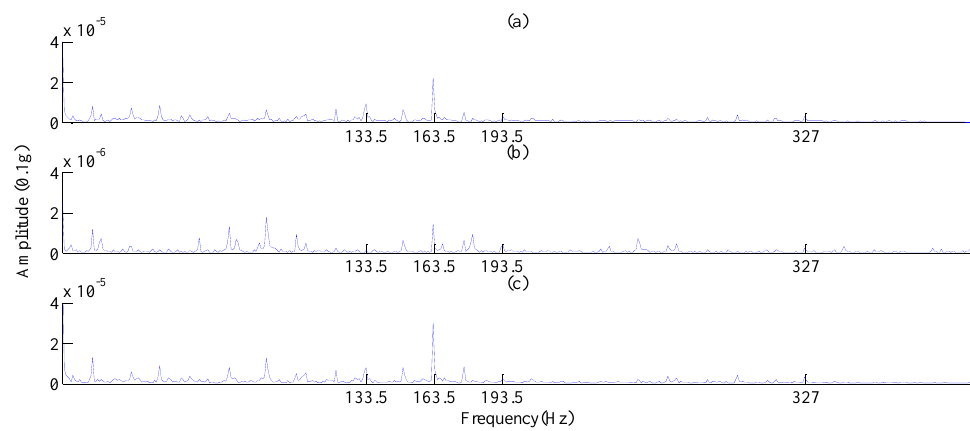
Figure 15. Main subband envelope spectra: ( a ) High-resonance component; ( b ) Low-resonance component; ( c ) Original signal [47].